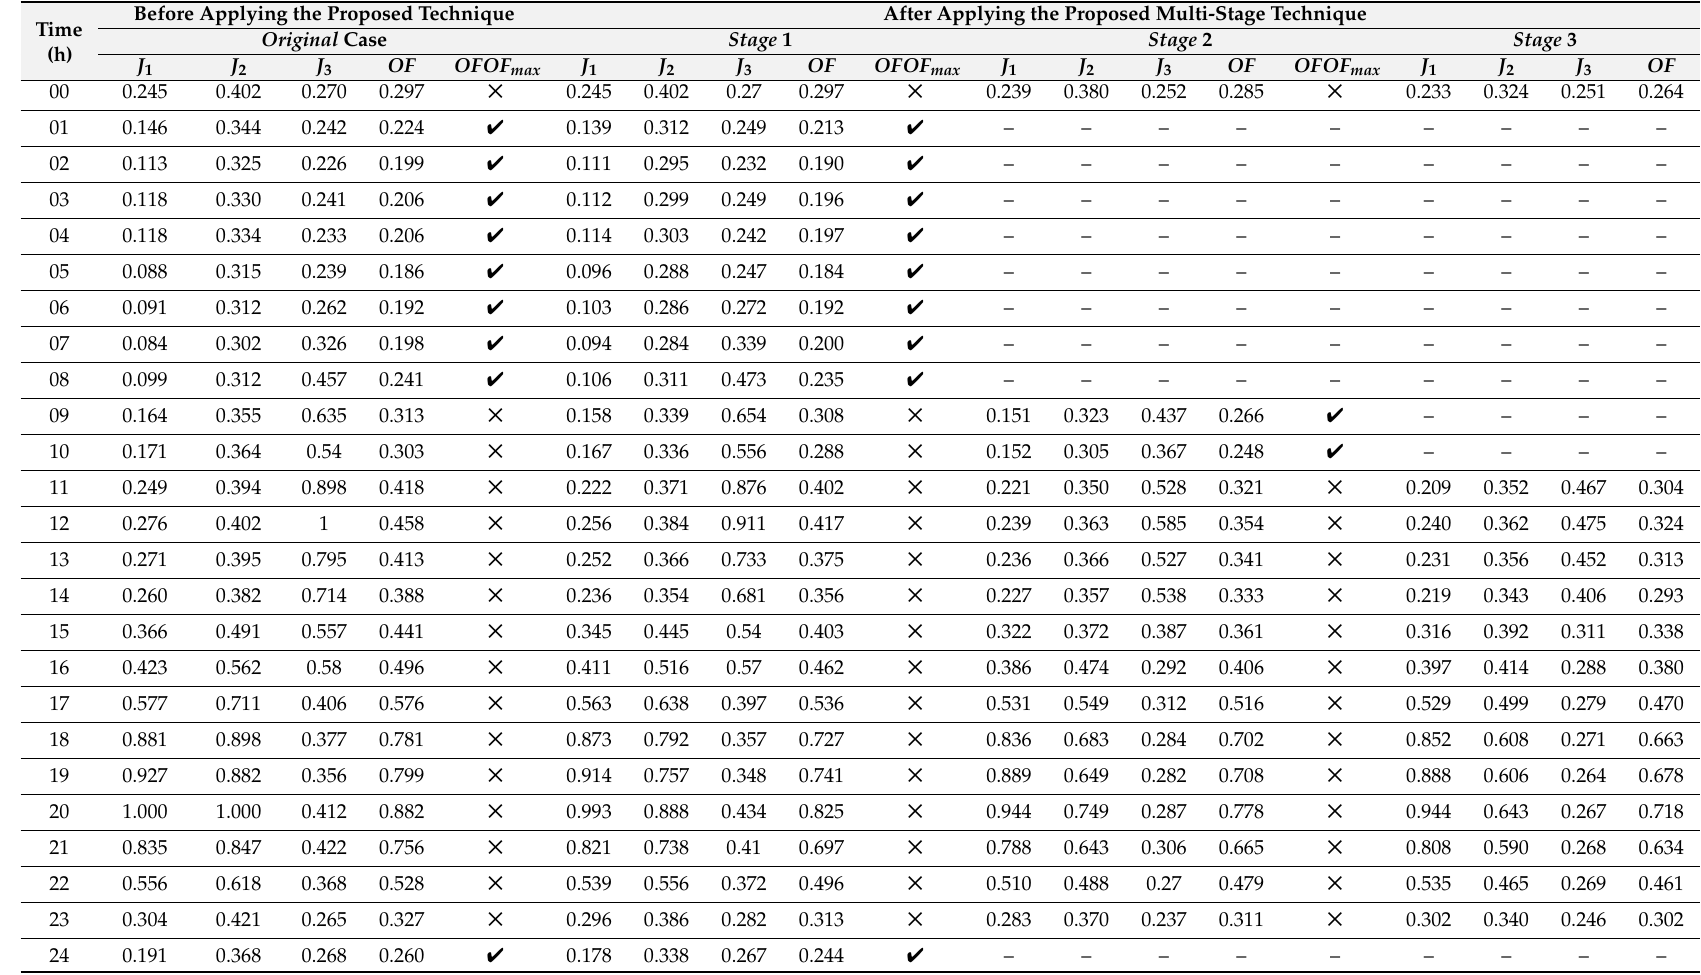
Table 2. Network operation compared over a 24-h period before and after applying the developed optimal VV